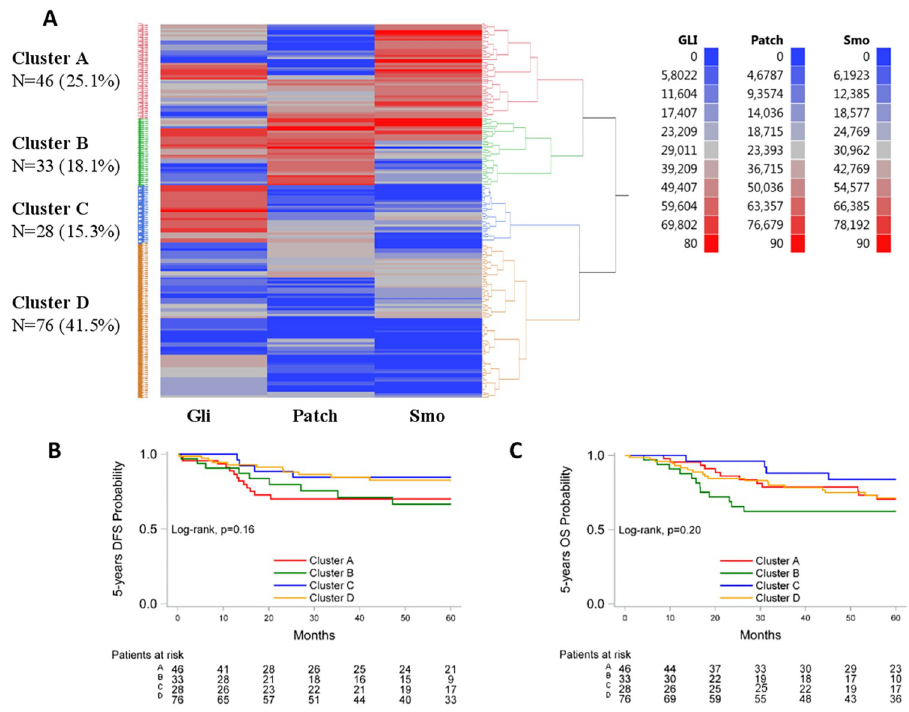
Fig 4. Evaluation of the Hedgehog pathway activation patterns. A: Hierarchical clustering of continuous IHC measurements for the assessment of the Hedgehog pathway activity patterns, N = 183. B, C: Kaplan-Meier curves according to cluster membership. B: 5-year DFS; C: 5-year